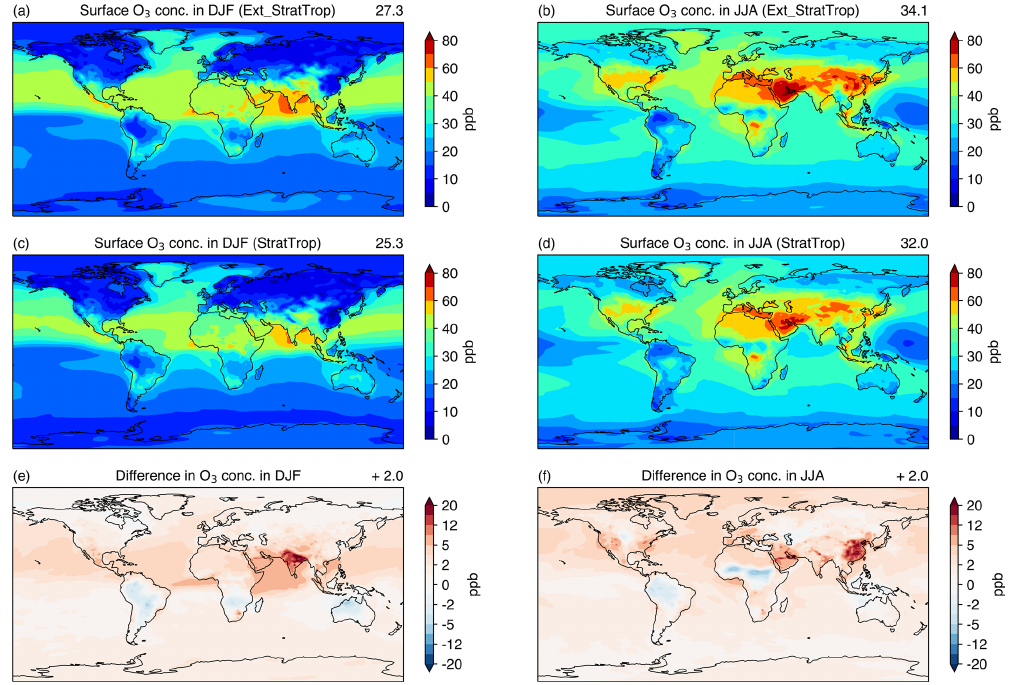
Figure 1. Comparison of present-day seasonal mean surface O 3 mixing ratios (2004–2014) between the Ext_StratTrop chemistry scheme (a, b) and the StratTrop chemistry scheme (c, d) . Winter time (December–January–February, DJF) and summer time (June–July– August, JJA) global mean O 3 mixing ratios are shown. Seasonal differences in surface O 3 mixing ratios between the two chemistry schemes are shown in (e) and (f) .